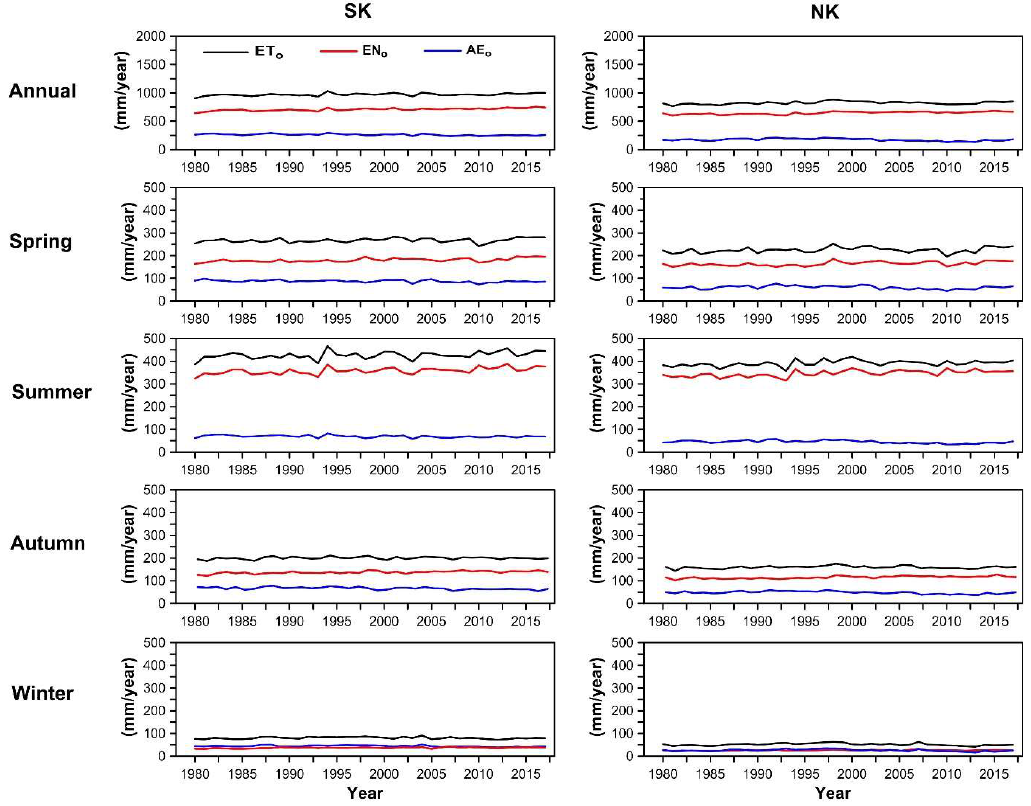
Figure 6. Difference between the amount of mean annual and seasonal ET o , EN o , and AE o in SK and North Korea (NK). Table 2. Mean seasonal and annual ET o , EN o , and AE o from 1980 to 2017 and ratios with ET o